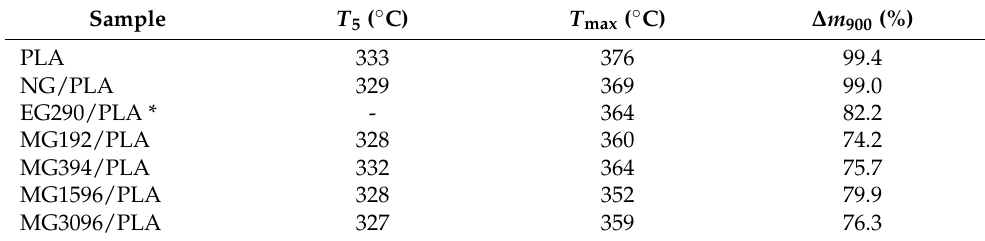
Table 2. Thermal parameters obtained from TG and DTG curves of graphite/PLA composites.